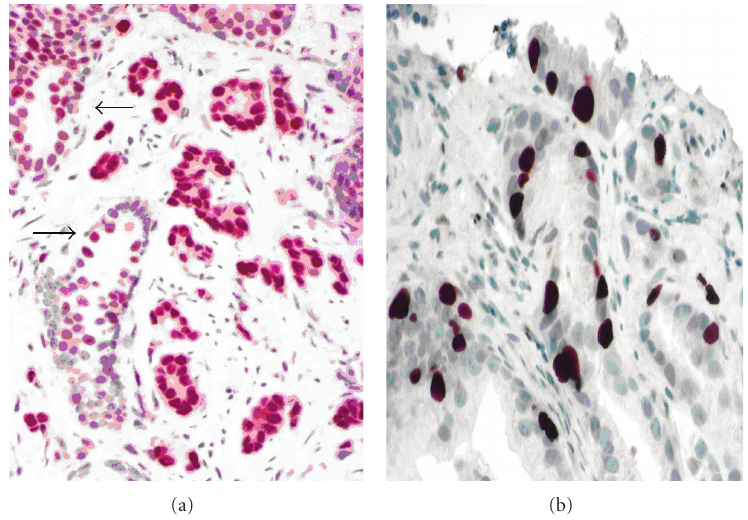
Figure 2: Androgen receptor (AR) status in hormone- and radio- na¨ıve PCa, Gleason 3 + 4 = 7 (Figure 2(a)). The AR is expressed at higher levels when compared with adjacent benign acini (arrows), indicating a hypersensitive pathway. Proliferation activity usually correlates with the Gleason grade. Figure 2(b) shows an example of a PCa, Gleason 3 + 3 = 6, with relatively high proliferation activity (MIB-1 index > 10%), which implies a higher risk of RT failure than the Gleason grade would suggest. Original magnifications: (a) ( × 300), (b) ( × 400).